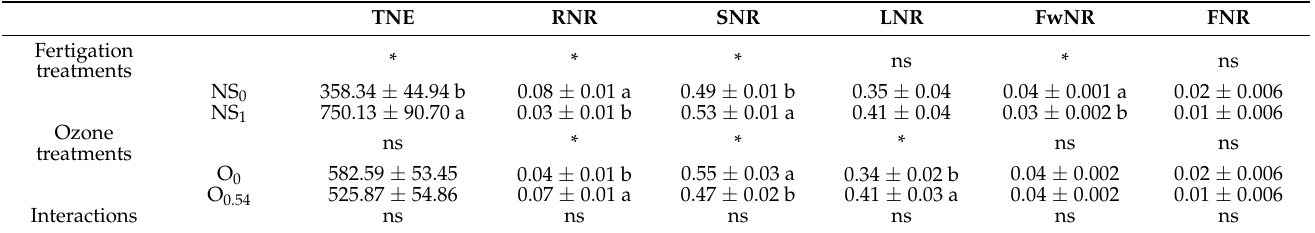
Table 11. Effect of fertigation and ozone on total nitrogen extracted by plant (TNE) (mg plant − 1 ) and their distribution in root (RNR), stem (SNR), leaf (LNR), flower (FwNR), and fruit (FNR) (dimension- less). The data recorded are the means ± standard deviation of four samples per treatment at the end of the experimental period. In each column, different letters or an asterisk (*) denote statistically significant changes between treatments (LSD test; p < 0.05). ns indicates non-statistical differences between treatments. TNE RNR SNR LNR FwNR